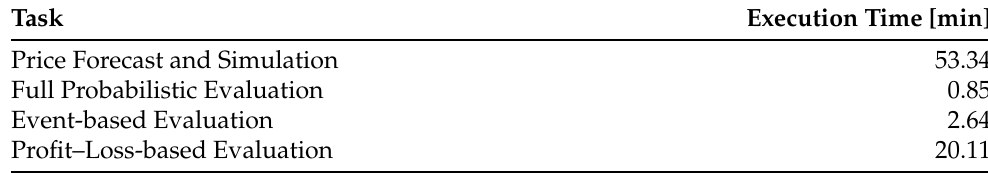
Table 3. Execution